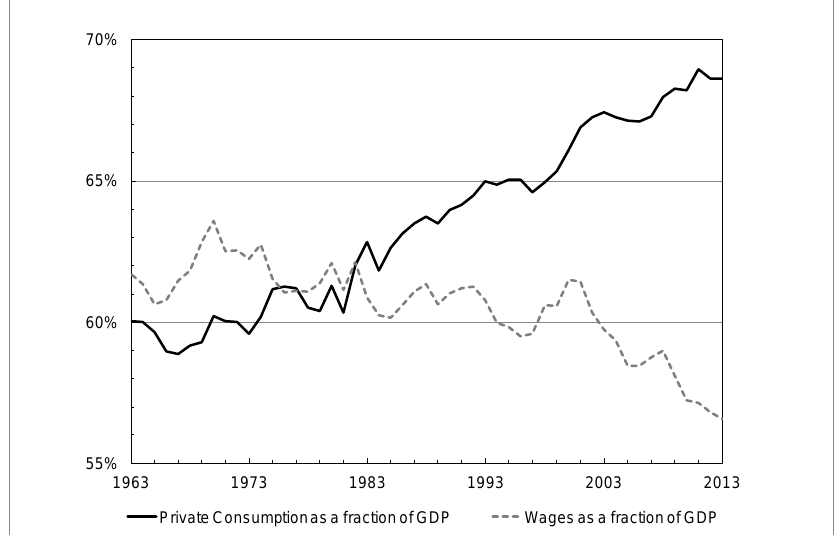
Figure 3. The share of wages and of private consumption as a percentage of the Gross Domestic Product (GDP) for the U.S. from 1963 until 2013. Source of data: Ameco, the Annual Macro-Economic Database of the European Commission [3], and Michel Husson, [4].